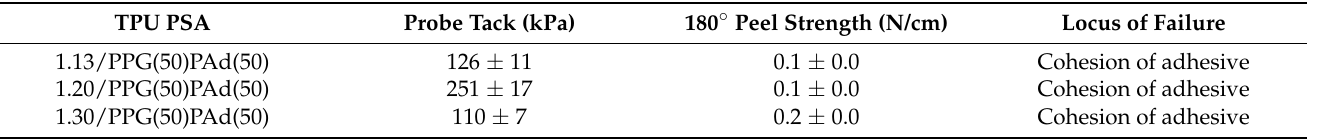
Table 12. Probe tack and 180 ◦ peel strength values strength of aluminum 5754/TPU PSA with different NCO/OH ratios joints, and loci of failure.